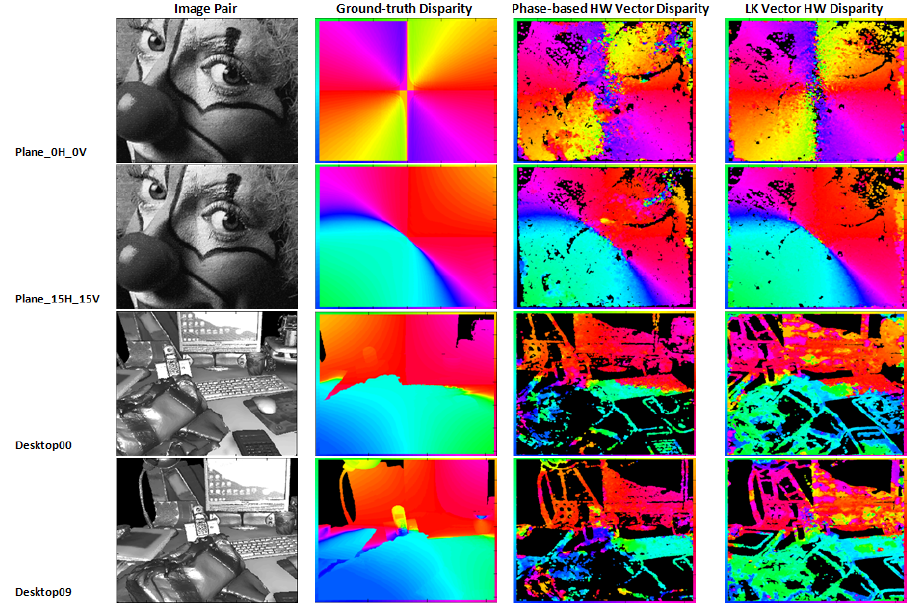
Figure 10. Hardware benchmark results for vector disparity. From left to right: original image, ground-truth, hardware results for phase-based, and Lucas–Kanade algorithms. The frame codes the vector disparity with a